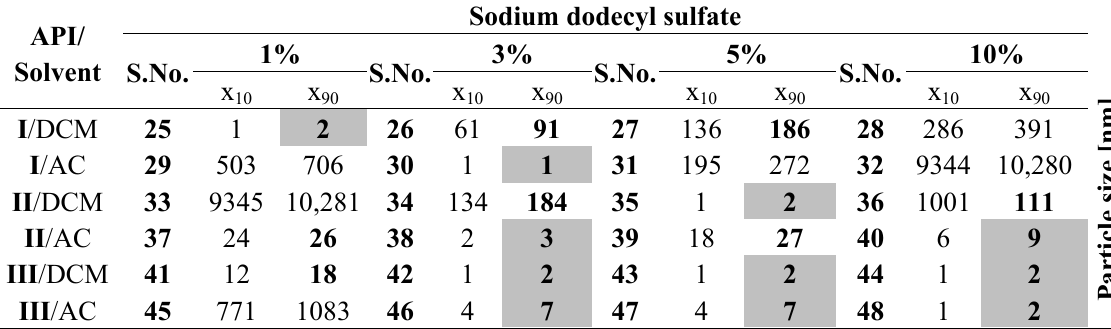
Table 2. Particle size (x , x [nm]) of APIs I – III and concentration [%] of sodium 10 90 dodecyl sulfate in dichloromethane (DCM) or acetone (AC). All the presented results are reported as medium value of four independent measurements, repeatability was up to 6%. Samples that contained nanoparticles <200 nm are bolded; nanoparticles <10 nm are indicated by grey background. (S.No. = sample number).